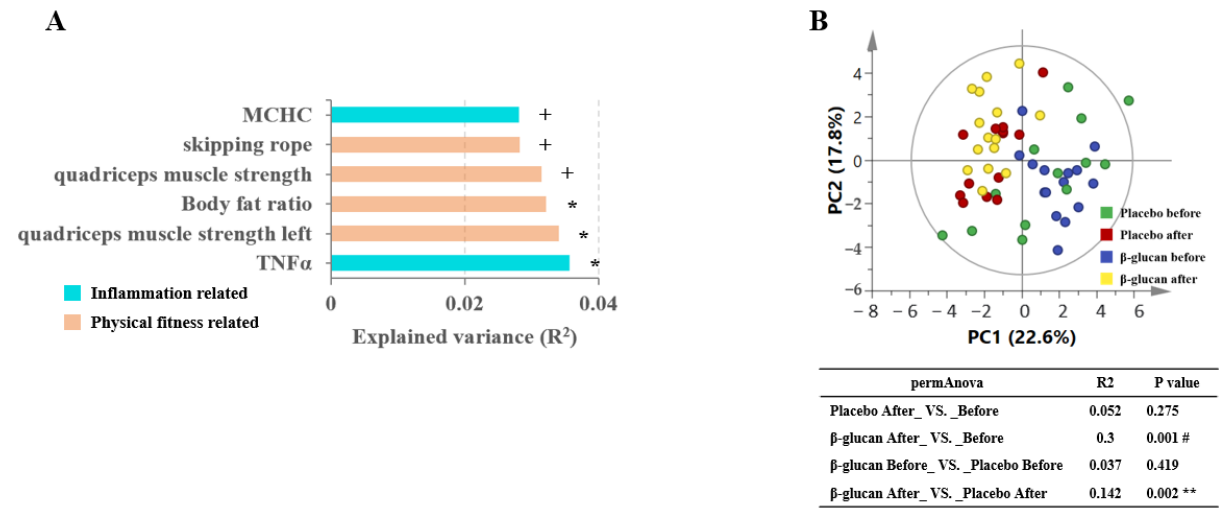
Figure 2. Effects of β -glucan on the metabolite composition of plasma metabolomes in athletes . ( A ) The effect size of phenotype indices contributed significantly to the variance (R2) of the plasma metabolome ( + p < 0.1, * p < 0.05, ** p < 0.01, # p < 0.001). ( B ) The principal component analysis (PCA) of the plasma metabolites between the placebo and β -glucan groups based on the permutational multivariate analysis of variance (PERMANOVA test with 10,000 permutations) ( + p < 0.1, * p < 0.05, ** p < 0.01, # p <